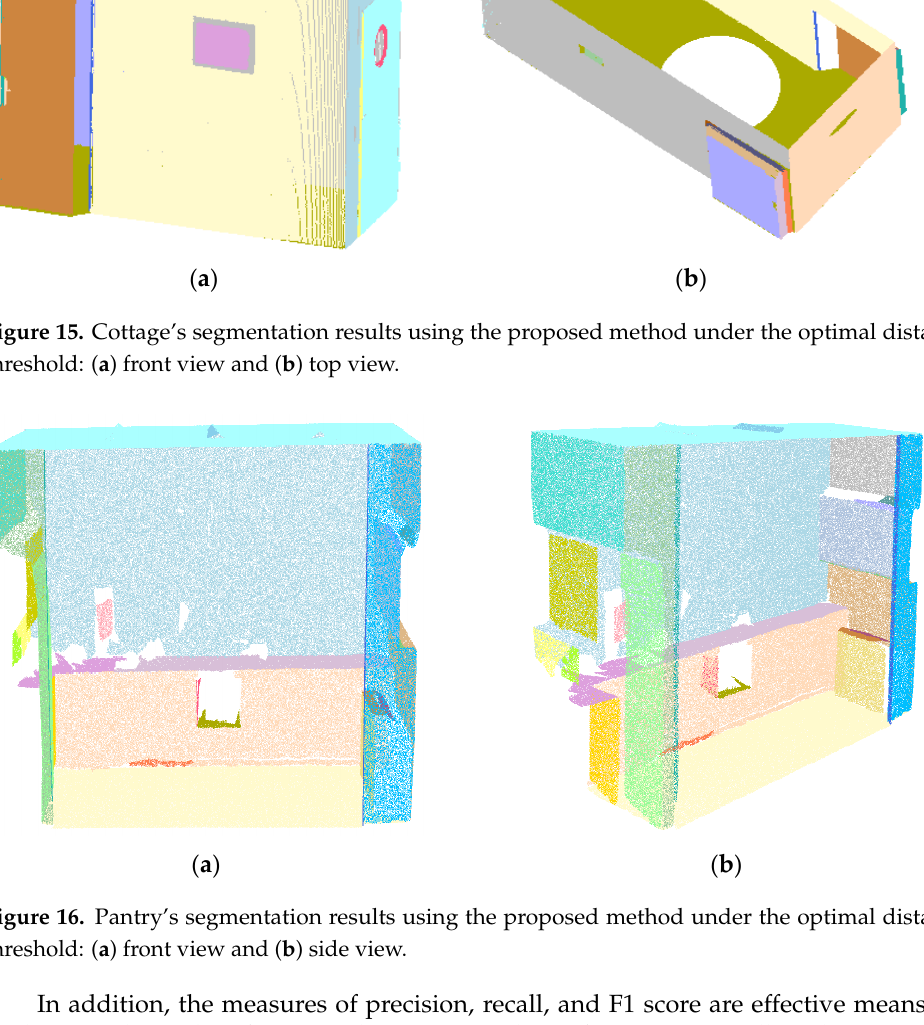
Figure 16. Pantry’s segmentation results using the proposed method under the optimal distance threshold: ( a ) front view and ( b ) side view.